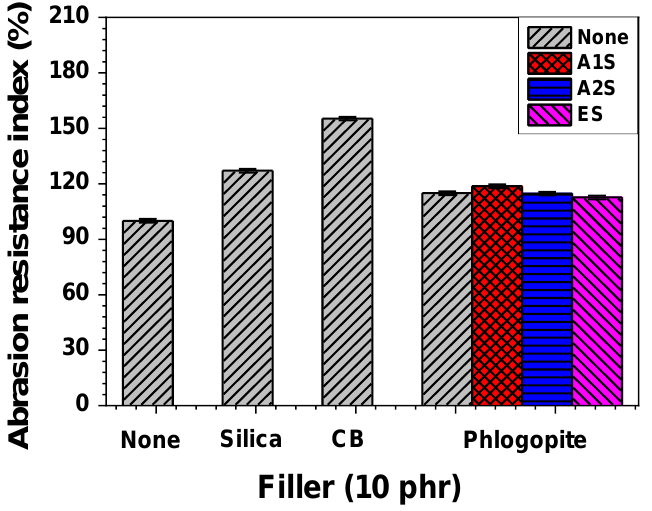
Figure 5. Abrasion resistance index (ARI) of the NR/EPDM blend and composites with different fillers and functionalization types (amino- and epoxide-functionalized) for phlogopite. The elastic characteristics of rubbers can be investigated by measuring its rebound resilience and compression set, as shown in Figure 6. The rebound resilience refers to a ratio of the energy returned to the energy applied for deformation by an external force. The compression set represents the degree of deformation sustained when the force is removed after a rubber sample is deformed by a force at a high temperature for a certain period of time. Thus, low compression set values indicate high elasticity. The incorporation of A2S- and ES-functionalized phlogopite into the NR/EPDM rubber matrix enhanced the rebound resilience and reduced the compression set, which indicates good elasticity. However, the elasticity of the A1S-functionalized phlogopite/NR/EPDM was similar to that of the untreated phlogopite/NR/EPDM composite owing to the low concentration of amino moieties in A1S, which resulted in low compatibility [48–51]. The rebound resilience values of the various phlogopite-embedded composites were higher than those of the silica- or CB-incorporated composites, whereas compression set values of phlogopite/NR/EPDM composites were higher than those of silica- or CB-embedded composites. This finding indicates that the elastic properties for the rubber composites containing silica or CB under thermo-pressure conditions during compression set tests were superior to those of phlogopite-incorporated NR/EPDM rubber composites.